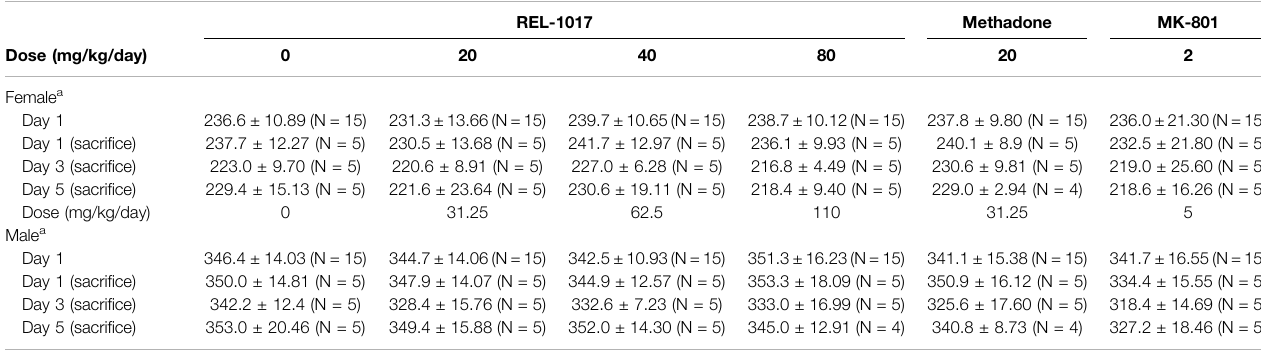
TABLE 3 | Body weight of animals during the